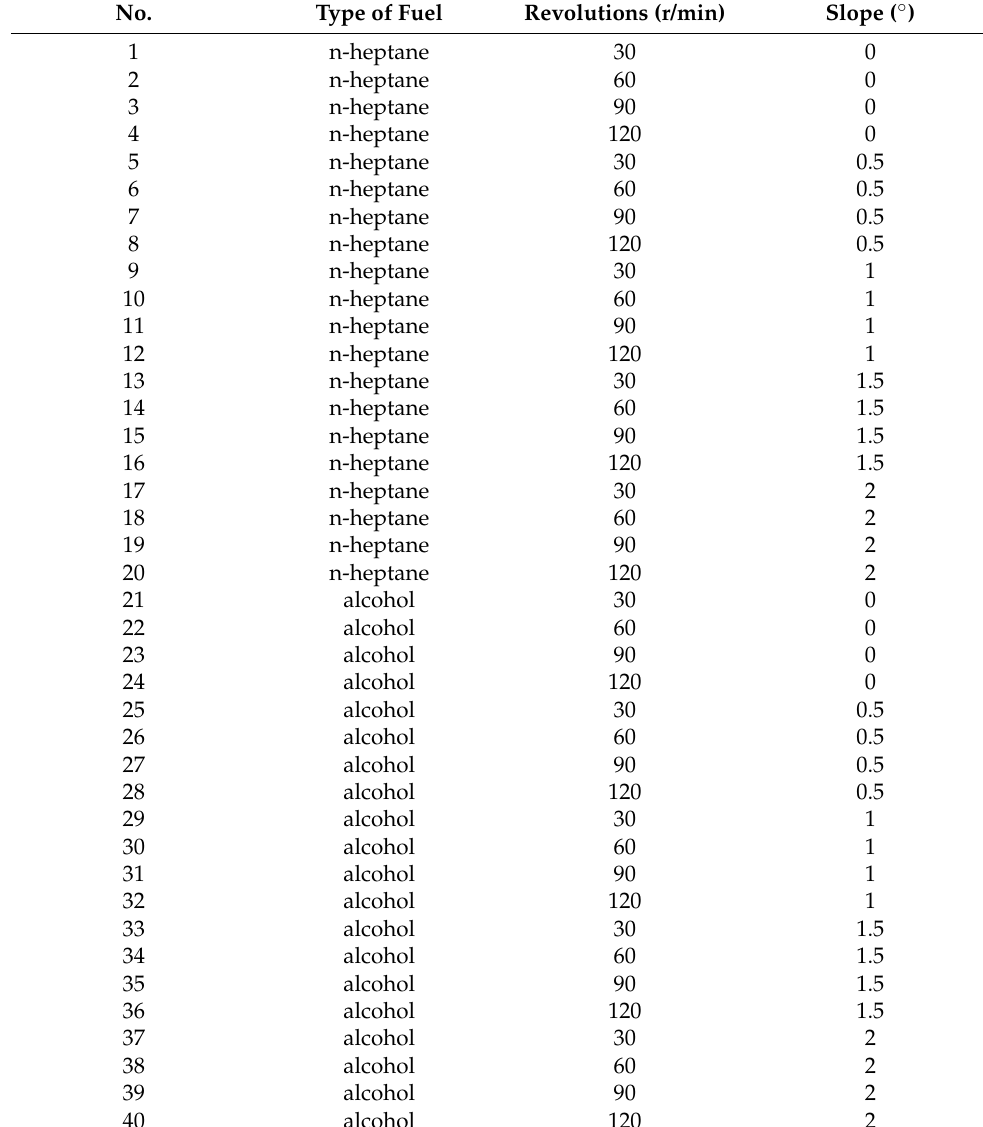
Table 3. Specifications of test